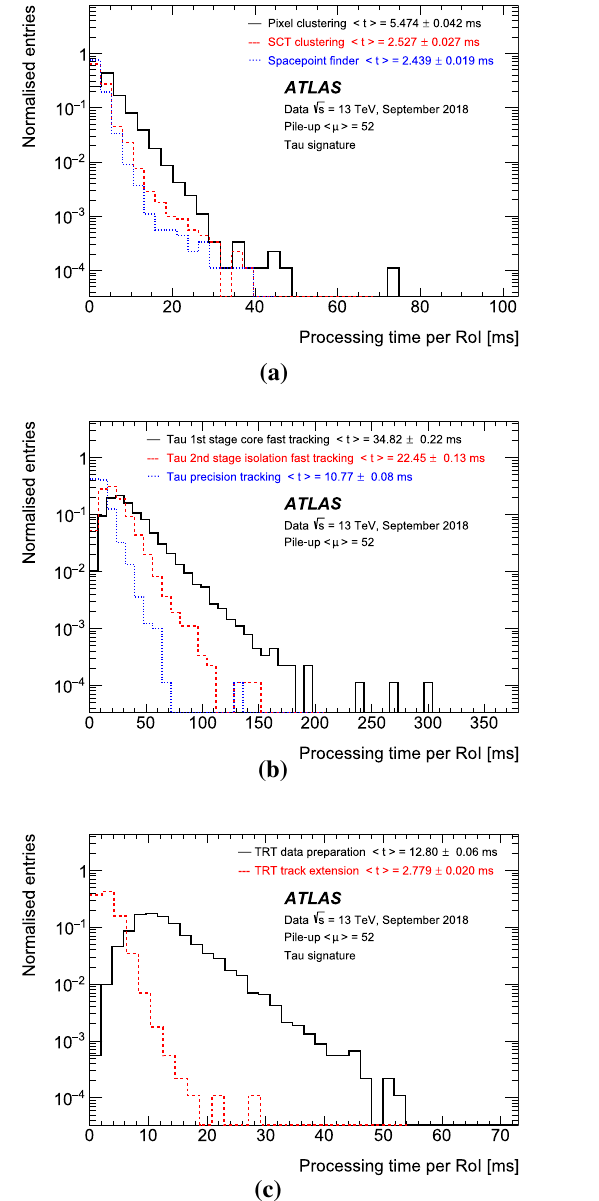
Fig. 14 The processing time for b -jet tracking related algorithms; a the data preparation times, b the tracking algorithm times, and c the TRT data